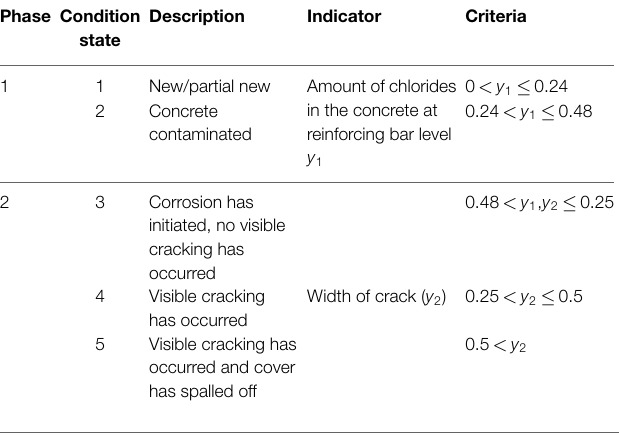
TABLE 3 | Estimated Markov transition probabilities